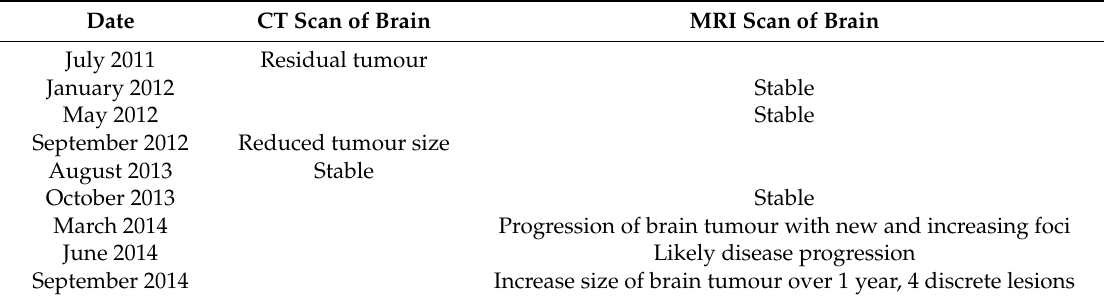
Table 1. Computerised tomography (CT) and magnetic resonance imaging (MRI) scans of